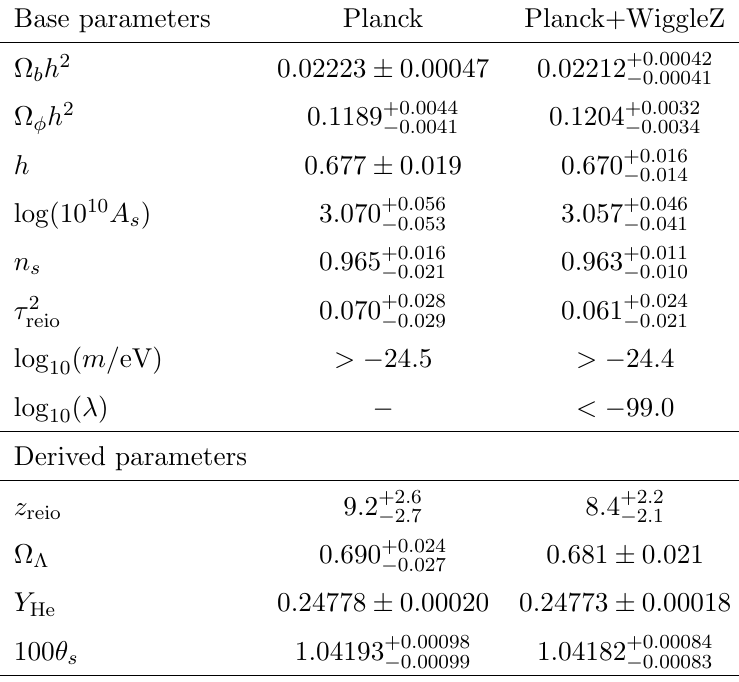
Planck Planck+WiggleZ